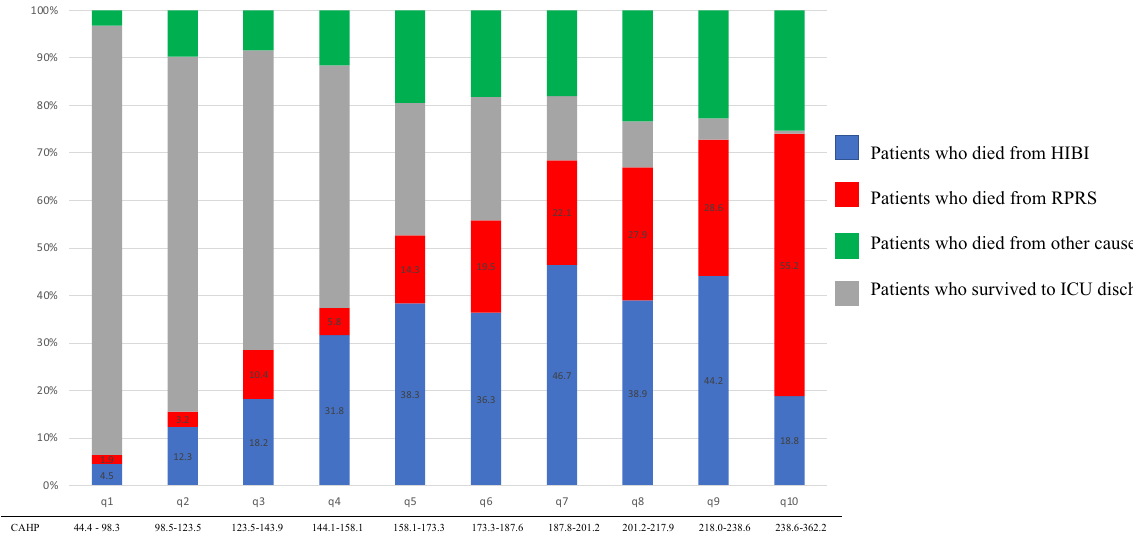
Figure 2. Outcomes according to CAHP score decile. The distribution of outcome is in percent. Each decile of CAHP had 154 patients. CAHP cardiac arrest hospital prognosis, HIBI hypoxaemic–ischaemic brain injury, RPRS refractory post-resuscitation shock, ICU intensive care unit.